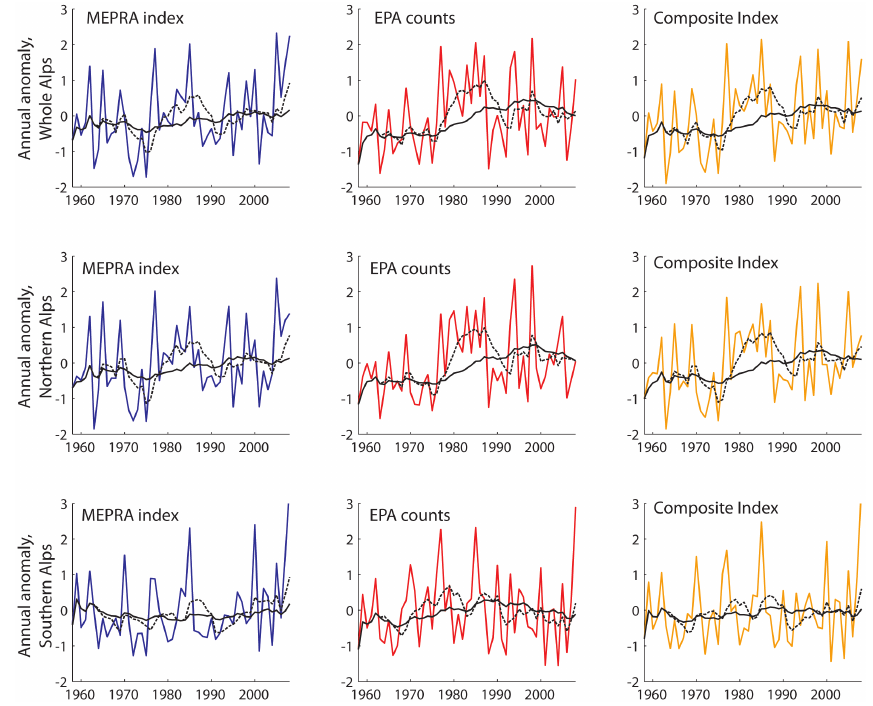
Fig. 2. Variations in annual anomalies of the MEPRA index (in blue), EPA counts (in red) and the composite index (in orange) over the whole French Alps, the Northern French Alps, and Southern French Alps. Moving averages over 20 and 5yr are represented in black solid and dashed lines,